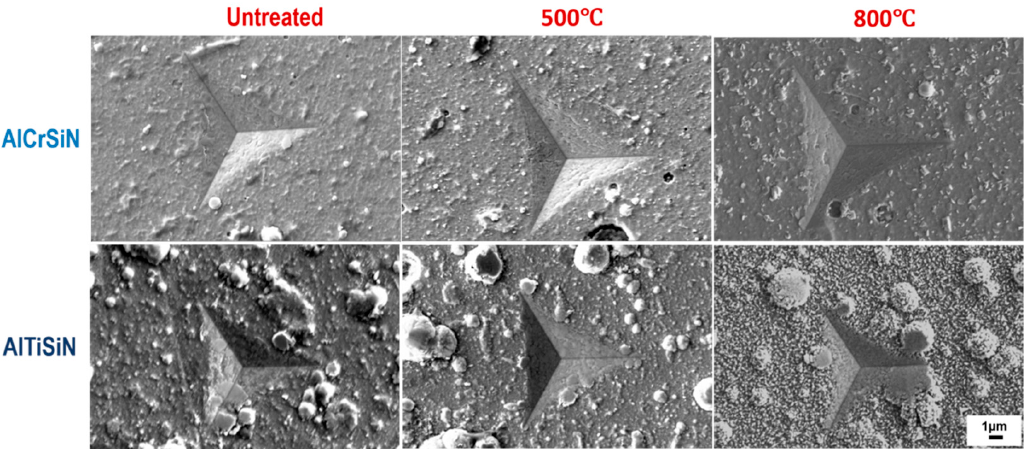
Figure 3. The SEM image of nanoindentation of AlCrSiN and AlTiSiN deposited on steel substrate after thermal treatment. Table 6. Vickers hardness of the